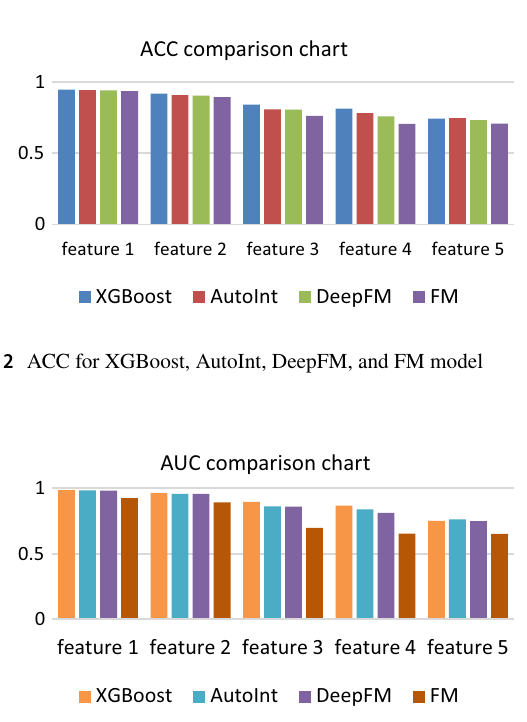
Fig. 3 AUC for XGBoost, AutoInt, DeepFM, and FM